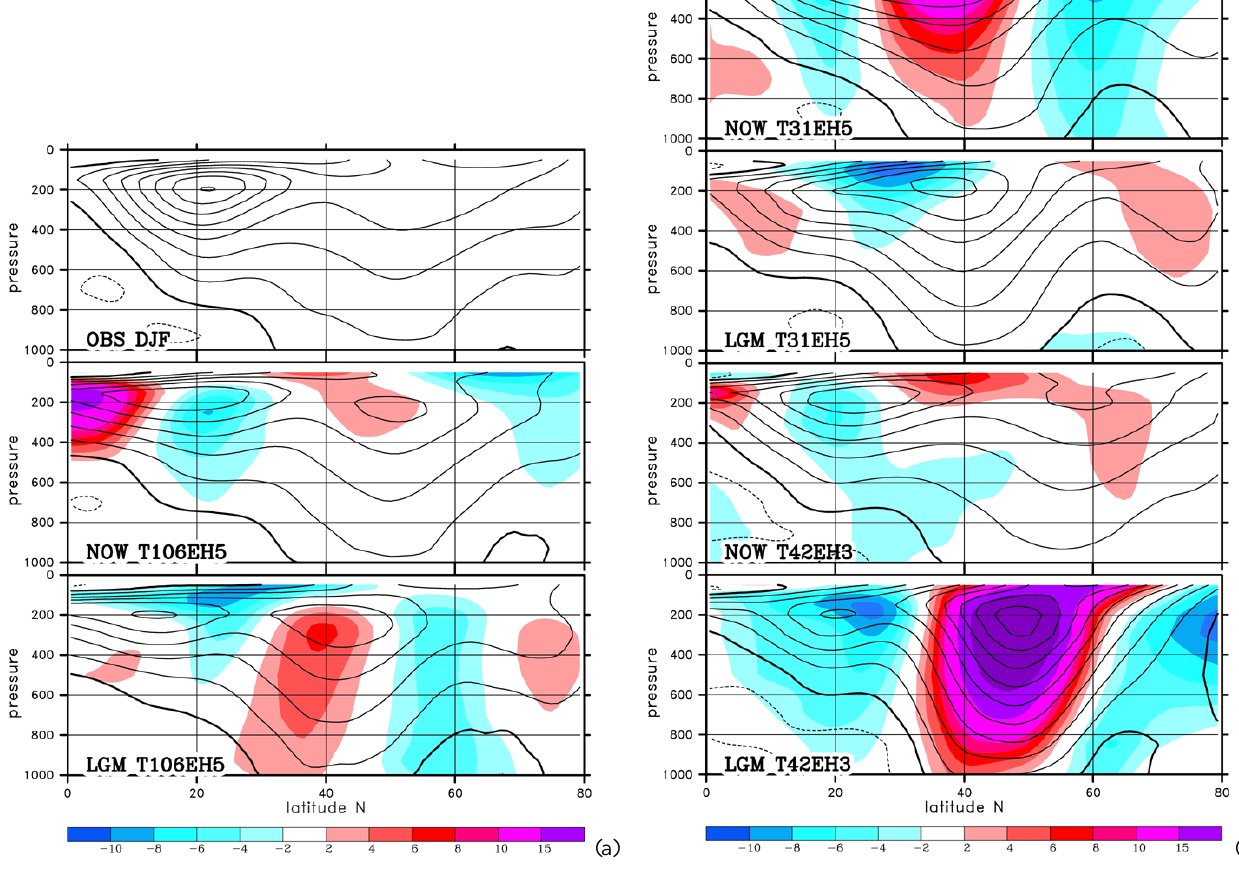
Fig. 4. Latitude-height cross-section of the zonal wind for winter (DJF) averaged between 30 ◦ W and 10 ◦ E. In the panels for the present (NOW) the differences to the observation are overlaid in colours, i.e. the model error, and in the panels for the LGM simulation the difference to NOW are overlaid in colours. Contours every 5ms − 1 , heavy line for the 0-zonal wind contour and dashes for negative values. Red colours for increases by more than 2ms − 1 and blue colours for decreases by more than 2ms − 1 . (a) Analysis (OBS) and T106EH5 simulation. (b) T31EH5 and T42EH3